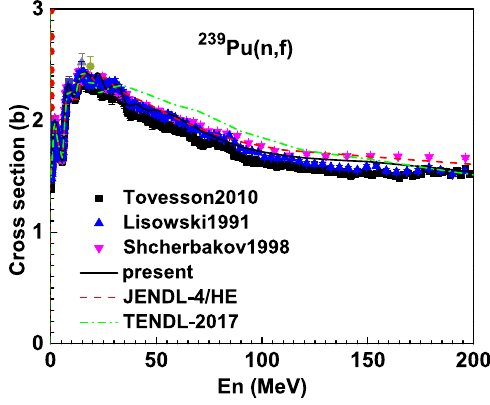
Figure 2. Same as Fig. 1, but for fission cross section.